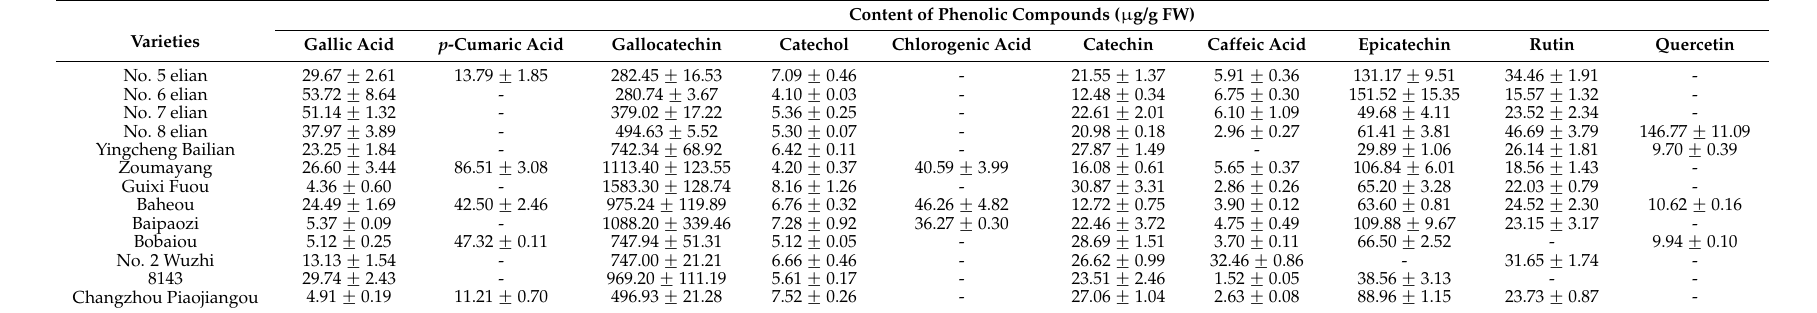
Table 3. Contents of individual phenolic compounds in the peels of lotus root varieties.